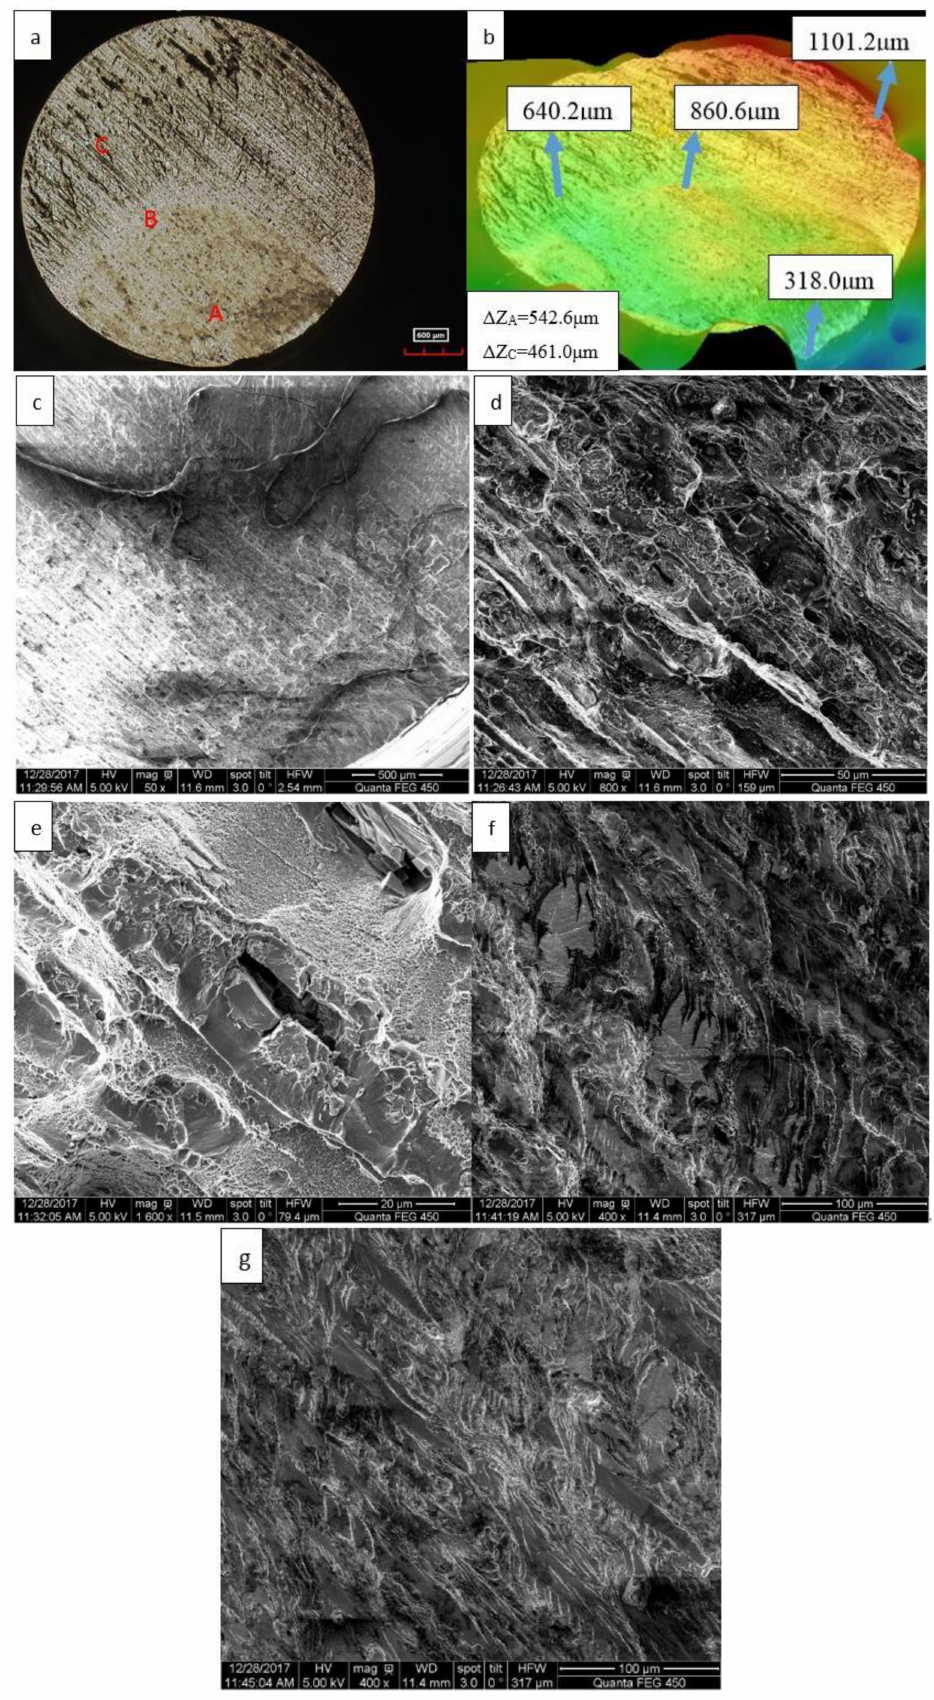
Figure 8. Fatigue fracture surface of N f = 8.126 × 10 5 , σ = 113.3 MPa in air for the uncoated sample. ( a ) Macro-scale view of the fracture surface; ( b ) Three-dimensional view of the fracture surface; ( c – e ) region labeled A; ( f ) region labeled B; ( g ) region labeled